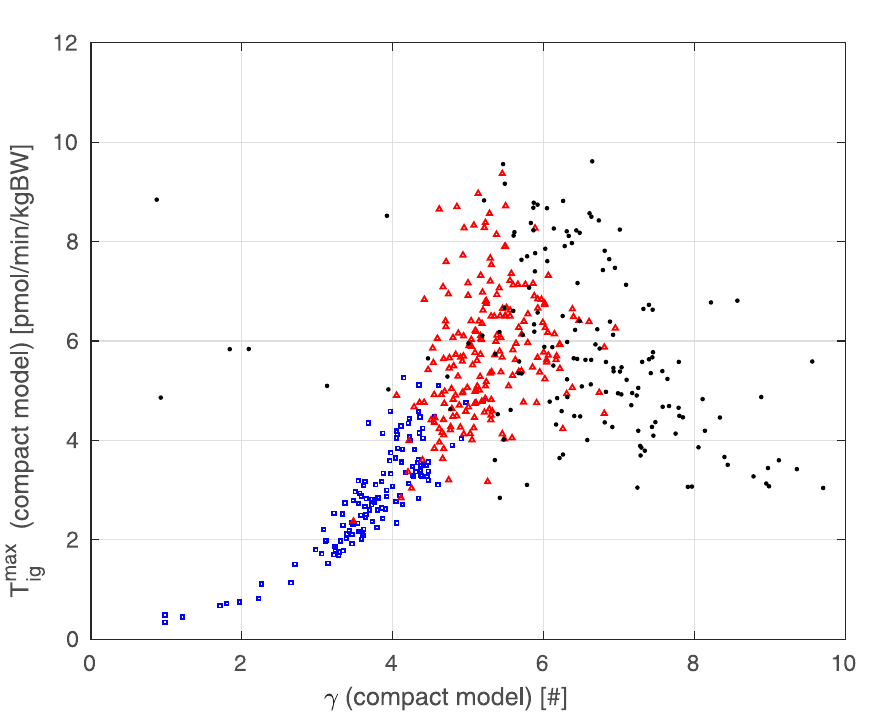
Fig 12. Dependence of Compact Model parameter T max Compact Model parameter γ for NGR (blue squares), pre-diabetic (red triangles) and T2DM (black dots) patients.